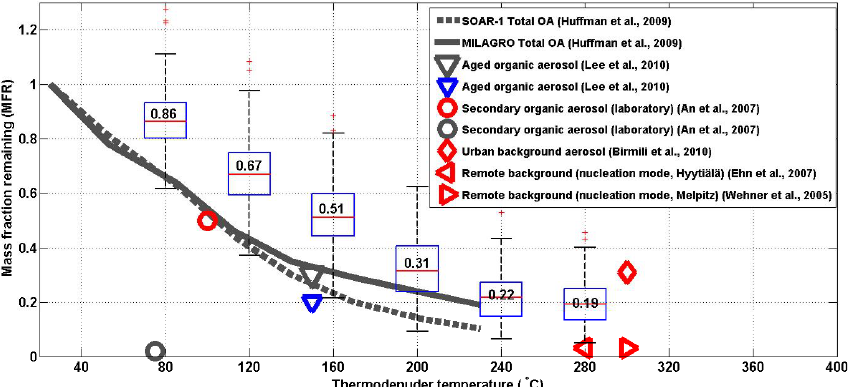
Fig. 6. Comparison of thermograms between this study (the boxplot) and previous volatility studies. Coloring describes the residence times used (red: < 2 s, grey: 10–16 s, blue: > 100 s). SOAR-1 and MILAGRO campaign results are adapted from Huffman et al. (2009). Lee et al. (2010) investigated the volatility of aged organic aerosol during FAME-2008 campaign in Finokalia and volatility measurements of urban background aerosol were performed by Birmili et al. (2010) in Germany. Ehn et al. (2007) and Wehner et al. (2005) measured the volatility of nucleation mode particles in Hyyti¨al¨a and in Melpitz, respectively. Measurement results of laboratory generated secondary organic aerosol from An et al. (2007) are also